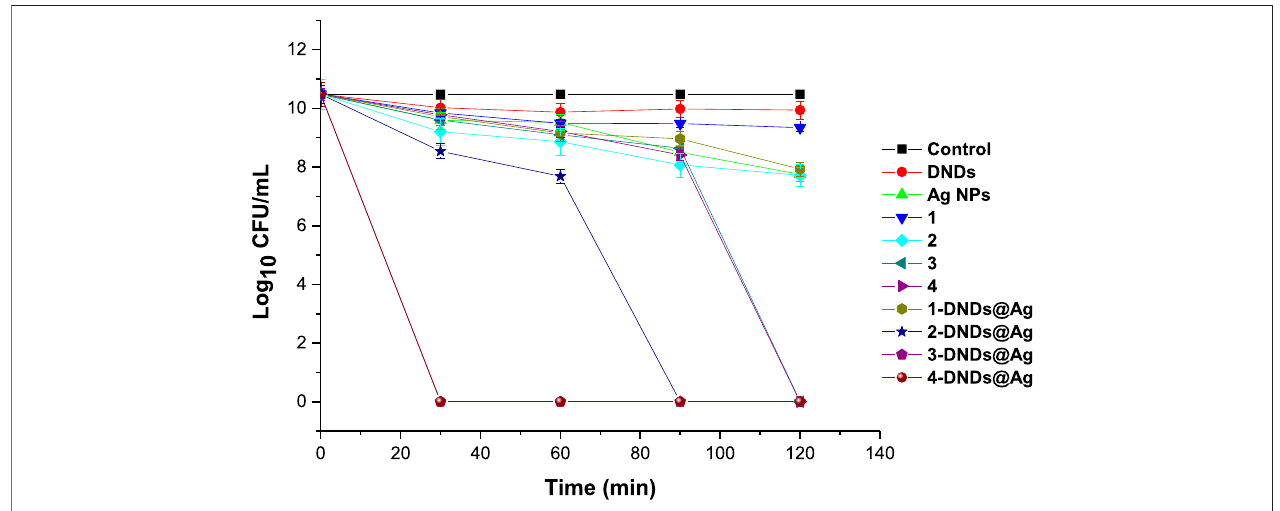
FIGURE 10 | Photoinhibition studies of the synthesized compounds on S. aureus planktonic cells (irradiation at 415 nm). Concentration (cid:2) 10 μ g/mL. Data represent the mean ± SD (standard deviation).